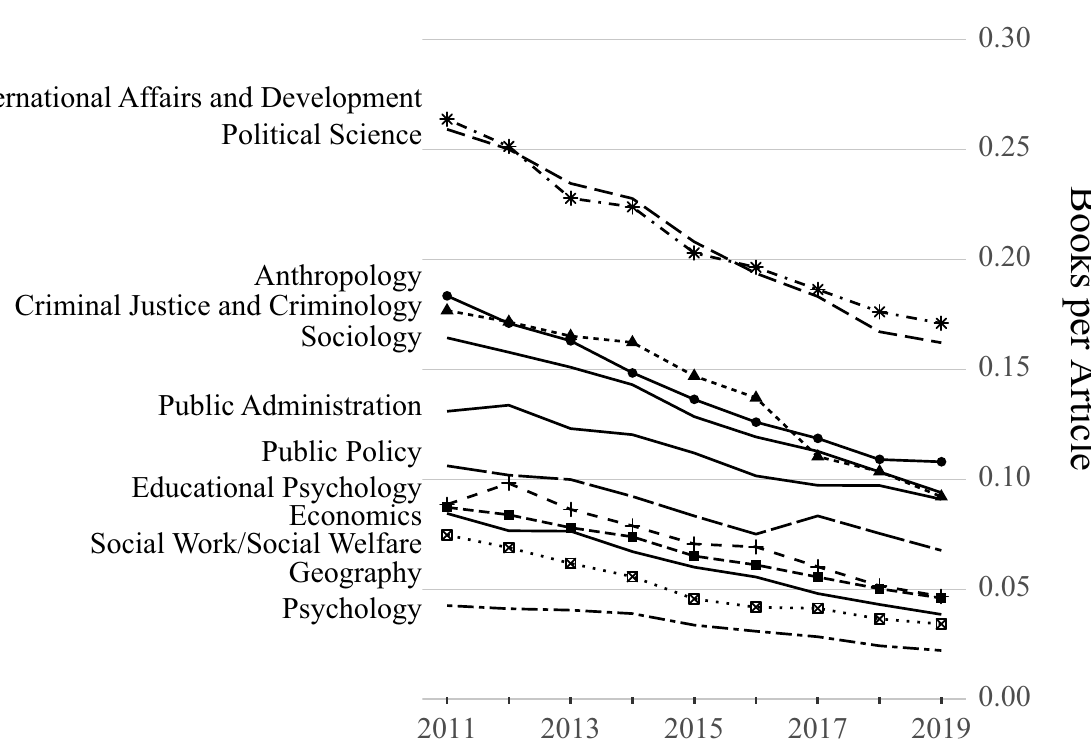
Fig 1. Books per journal article between 2011 and 2019. Both books and journal articles represent five-year sums, such that the 2011 data point represents the total books published between 2007 and 2011 divided by the total articles published between 2007 and 2011, the 2012 data point represents the total books published between 2008 and 2012 divided by the total articles published between 2008 and 2012, and so on.